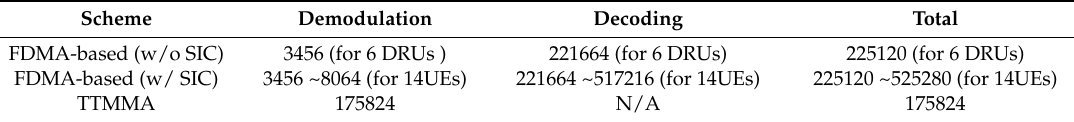
Table 4. Comparisons of computational complexity in number of